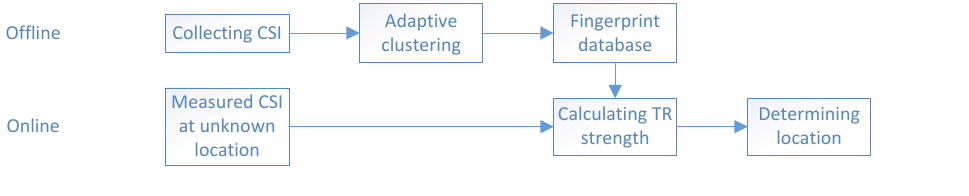
Figure 1. Architecture